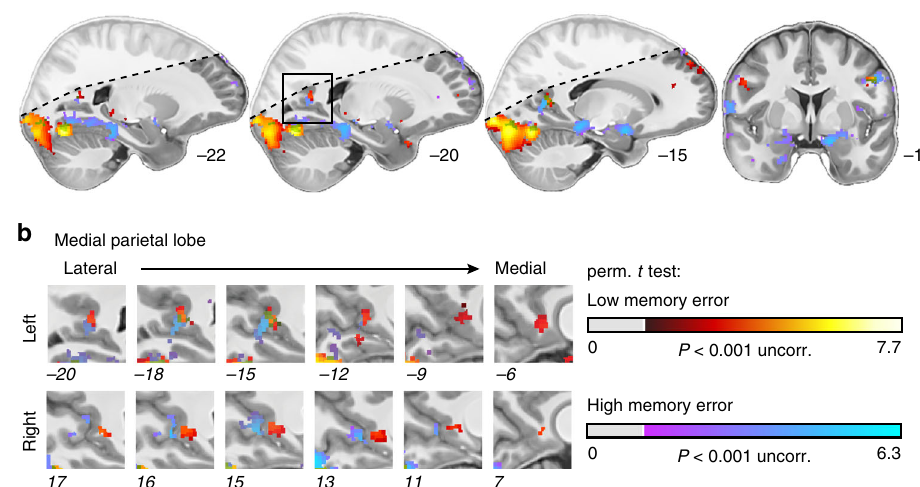
Fig. 4 Directional tuning topology re fl ects spatial memory performance. Participants were split into two groups depending on their across-trial median memory error (2× n = 10). a Tuning map: directionally tuned voxels were determined by testing model performance against zero on group level using a permutation-based t test with 1024 unique random possible shuf fl es. This procedure results in a minimal possible P value of 0.00098, precluding FDR correction. We therefore plot pseudo-T maps thresholded at P <0.001 uncorrected for all basis sets at T1 resolution overlaid on the group-average T1 scan. Hot colors depict results for the low-memory-error group, cool colors for the high-memory-error group. Approximate MNI coordinates added. b Zoomed-in depiction of the medial parietal lobe/retrosplenial cortex (RSC). There is an anterior – posterior distinction in directional tuning in RSC as a function of spatial memory performance. Shaded regions fell outside the scanning fi eld of view in at least one participant. Source data are provided as a Source Data fi cortex (RSC), parahippocampal gyrus (PHG), the posteromedial entorhinal cortex (pmEC), and the hippocampus (HPC) (Fig. 5a). We tested the pmEC subdivision of the entorhinal cortex because its rodent homolog region 31,32 is known to encode direction 33 – 35 . We obtained the vHD-model performance for every voxel in our